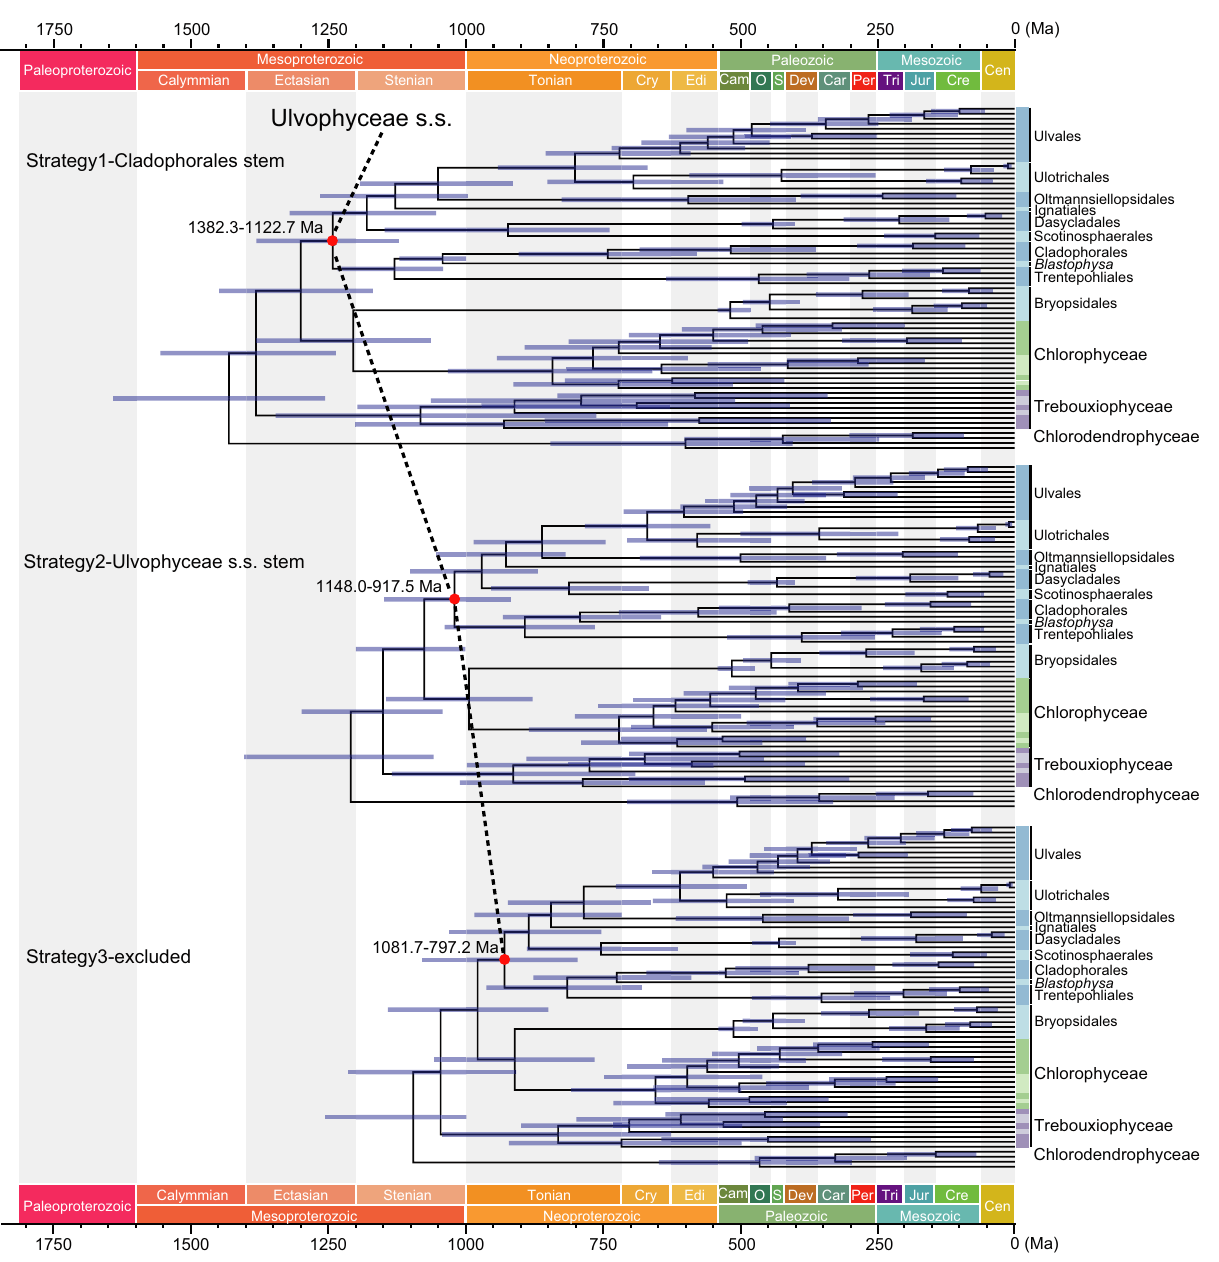
Fig. 4 Comparison of divergence time estimates from three fossil assignment strategies. The differences between the three calibration strategies refer to the placement of Proterocladus antiquus (strategy 1: P. antiquus to stem-group Cladophorales; strategy 2: P. antiquus to stem-group Ulvophyceae s.s.; strategy 3: exclusion of P. antiquus ). Node ages are plotted at the posterior means, with horizontal bars representing 95% credibility